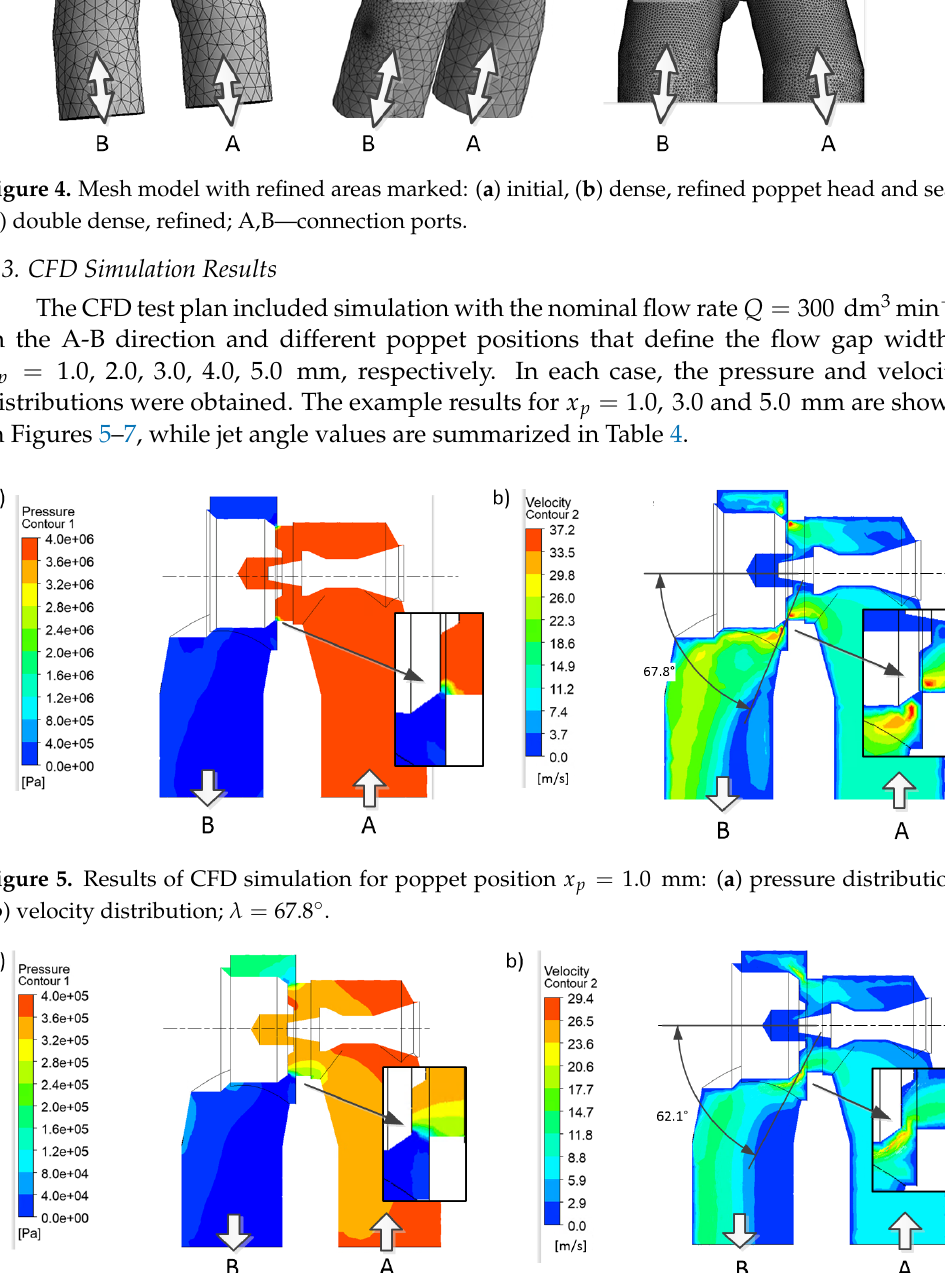
Figure 6. Results of CFD simulation for poppet position x p = 3.0 mm: ( a ) pressure distribution, ( b ) velocity distribution; λ = 62.1 ◦